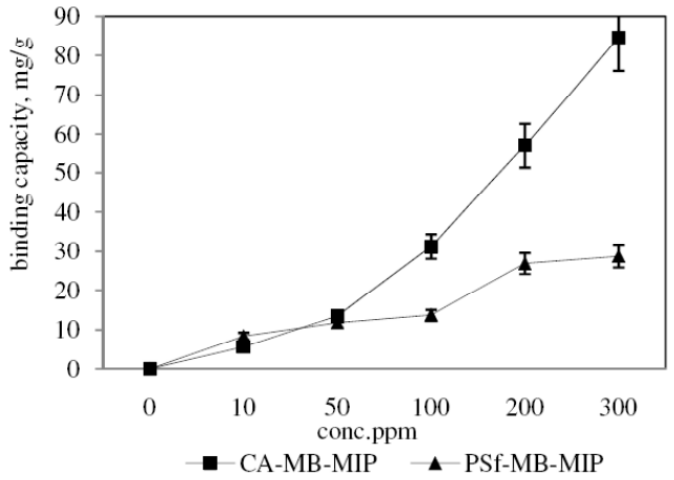
Figure 8. Sorption isotherms for the sorption of MB on CA-MB-MIP membrane and PSf-MB-MIP